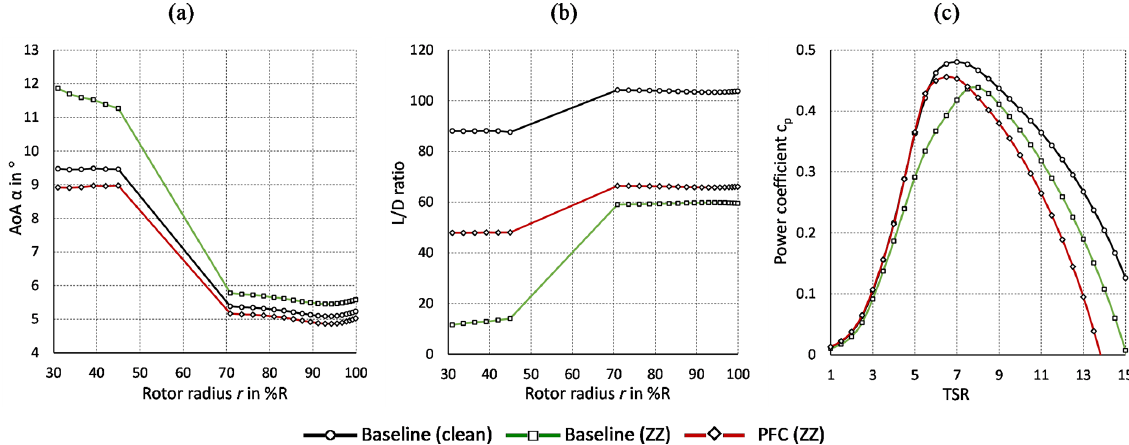
Figure 16. Rotor blade performance simulation of the baseline and the retrofit application. (a) AoA over rotor radius at λ opt = 7. (b) L/D over rotor radius at λ opt = 7. (c) Power coefficients over TSR.